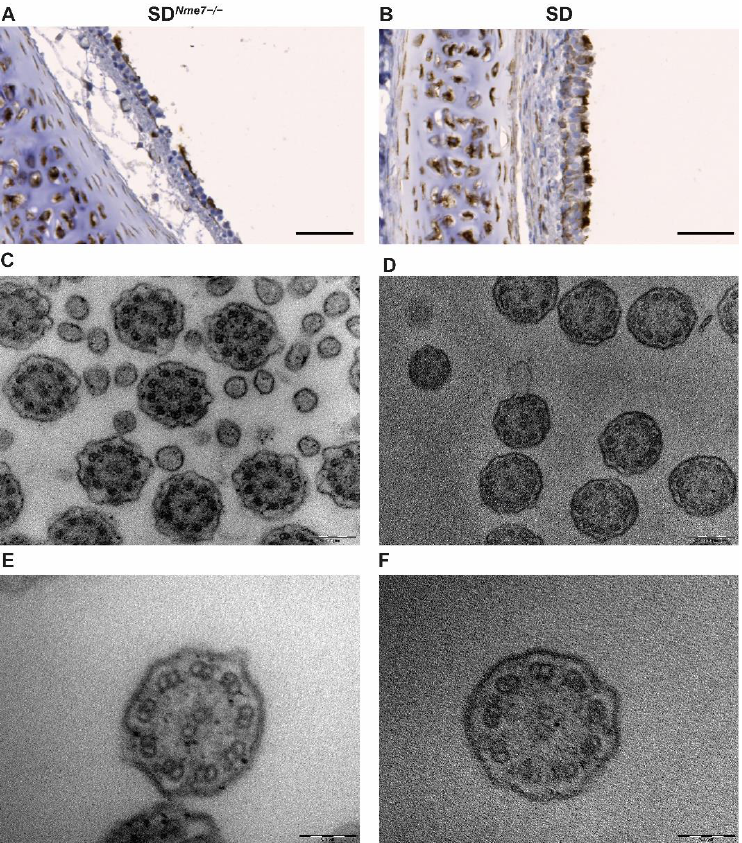
Figure 5. Acetylated α -tubulin staining in transversally sectioned trachea (( A , B ), the bar indicates 50 µ m). Cilia staining is evident in both SD Nme7 − / − ( A ) and SD control rats ( B ), even though the pseudostratified cilliated columnar epithelium is damaged and, in some parts, even missing in SD Nme7 − / − rats. Transmission electron microscopy of cilia in the trachea (magnification 56,000 × (( C , D ), the bar indicates 0.2 µ m) and 140,000 × (( E , F ), the bar indicates 0.1 µ m)) shows standard arrangement of the cilia ultrastructure on the cross-sectional view—nine outer doublets and one central pair (9 × 2 + 2) both in SD Nme7 − / − ( C , E ) and in SD control rats ( D , F ).